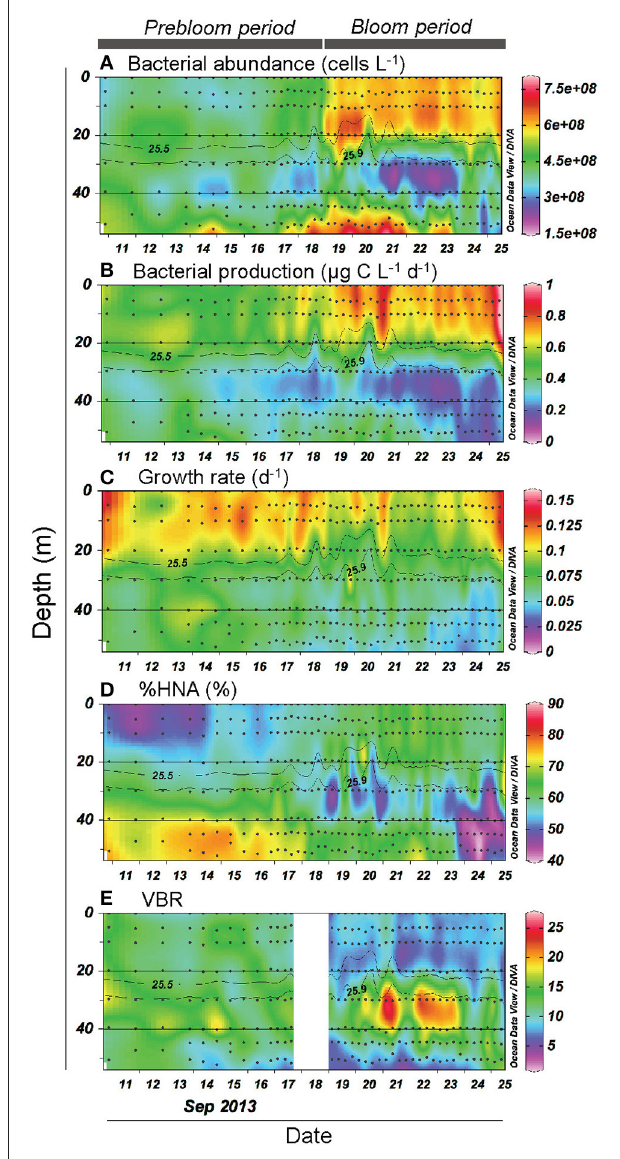
FIGURE 3 | Vertical and temporal variation in (A) bacterial abundance, (B) bacterial production, (C) growth rate, (D) percentage of high-nucleic-acid bacteria (%HNA), and (E) viruses-to-bacteria ratio (VBR). Gray contour lines indicate potential density ( σ θ ). The contour graphs were created using Ocean Data View software (Schlitzer,